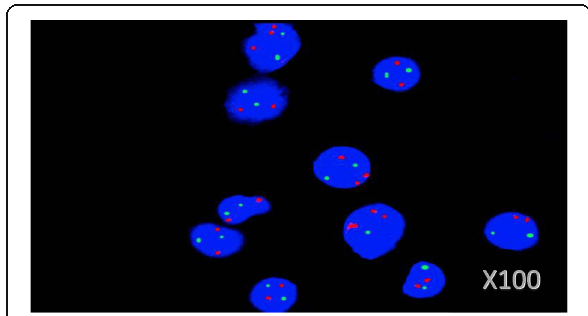
Fig. 2 FISH using hTERT (5p15) spectrum red and control on 5(q)spectrum green show amplification of hTERT (three red signals) in three interphase nuclei from AML patient